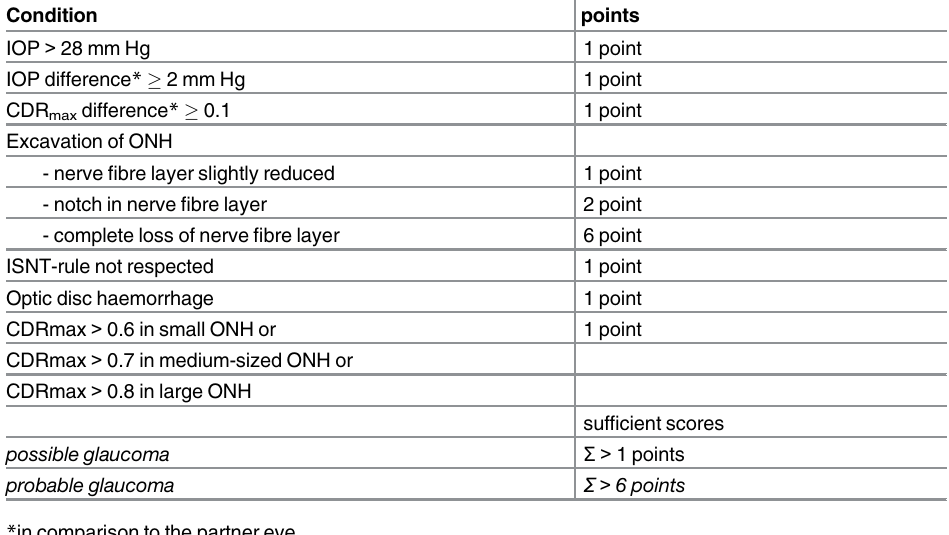
Table 1. Calculation of a glaucoma score for the classification into possible or probable glaucoma. The score was defined as the sum of the points. Calculation was performed for each eye